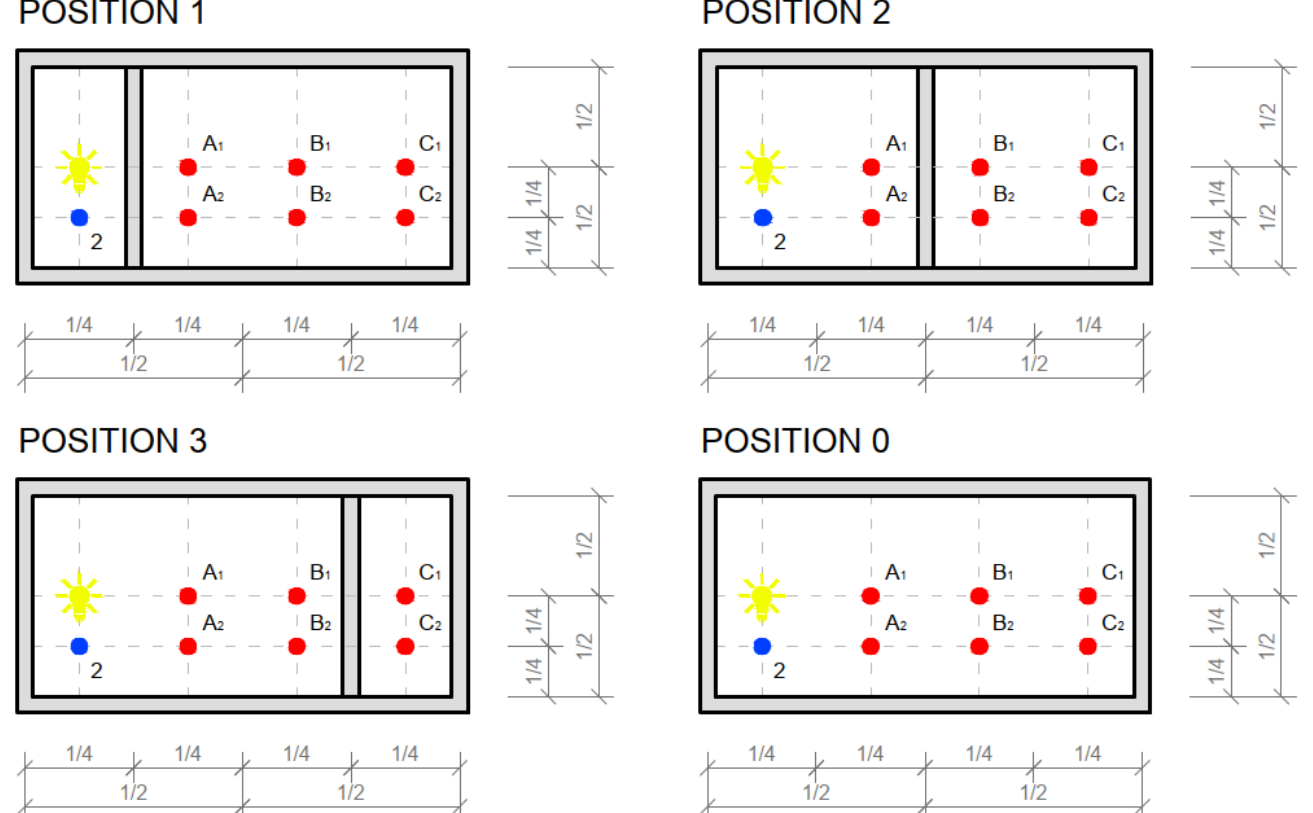
Figure 31. Plans and sections of the scaled-down model.